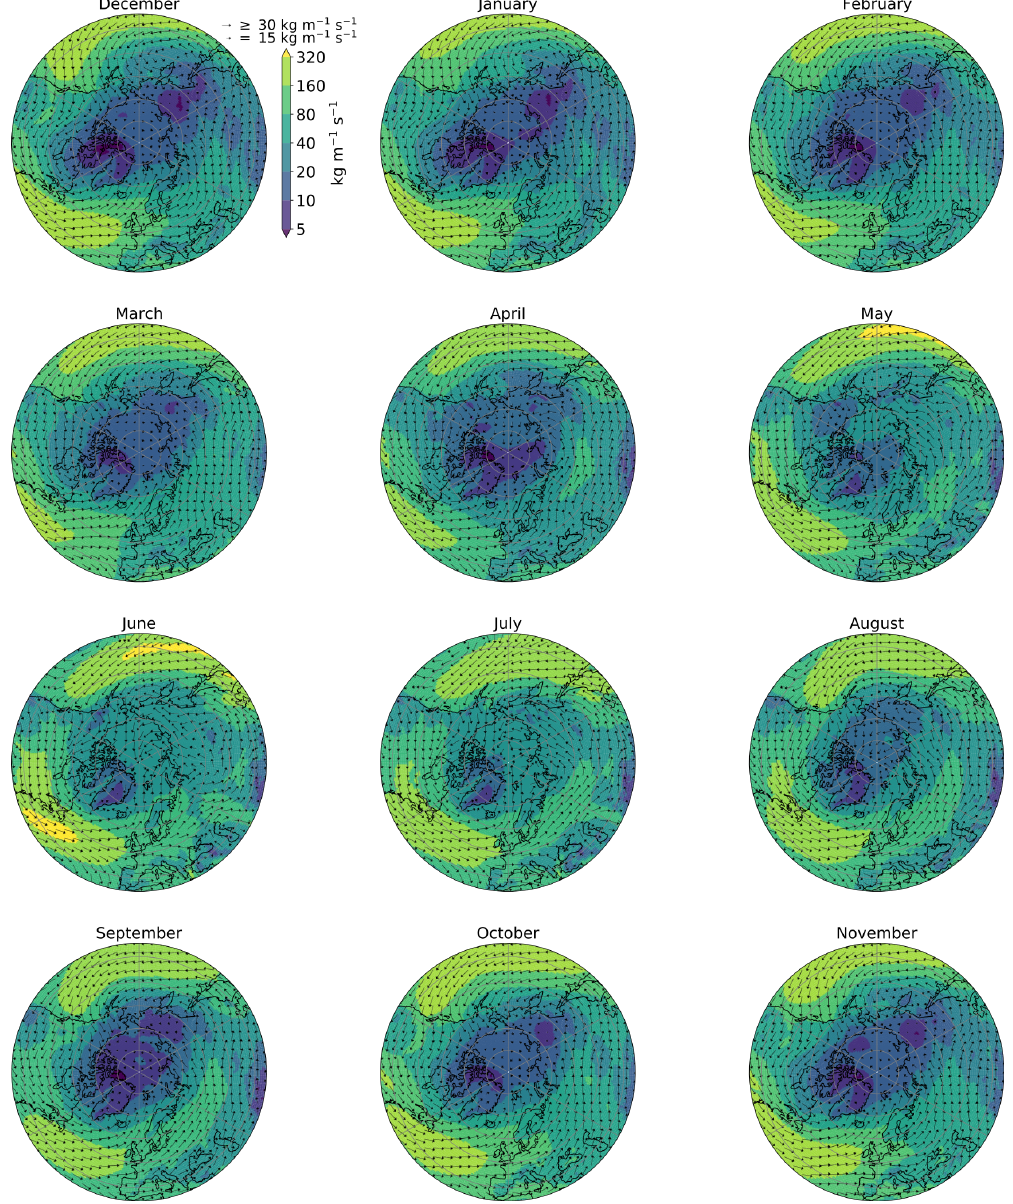
Figure 6. Annual cycle of integrated water vapour transport (ERA-Interim monthly mean of February 1979–May 2017) (35–90 ◦ N). The magnitude of IVT is depicted by the colours (note the uneven colour scale) and the arrows indicate the IVT direction. The same scale is applied for each month. For grid points with IVT < 30kgm − 1 s − 1 only, the arrow length also depicts the IVT